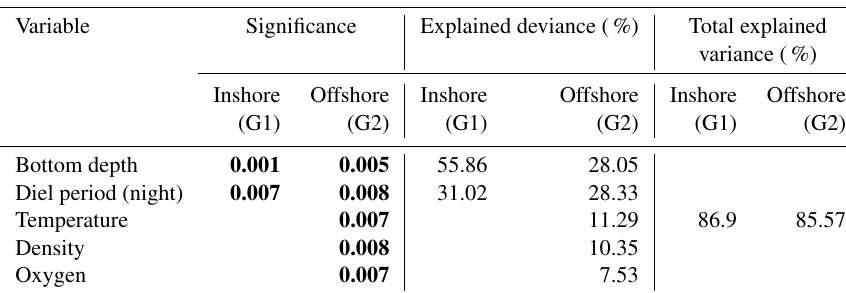
Table 1. Result of ANCOVA models between thickness of sound-scattering layers (SSLs) and environmental parameters (temperature, density, dissolved oxygen, chlorophyll a , diel period, and bottom depth) in the inshore area (G1) and the offshore area (G2). G1: multiple R 2 is 0.869, adjusted R 2 is 0.8515, and p value<0.001; G2: multiple R 2 is 0.8557, adjusted R 2 is 0.7956, and p value<0.001; significant p values in bold.